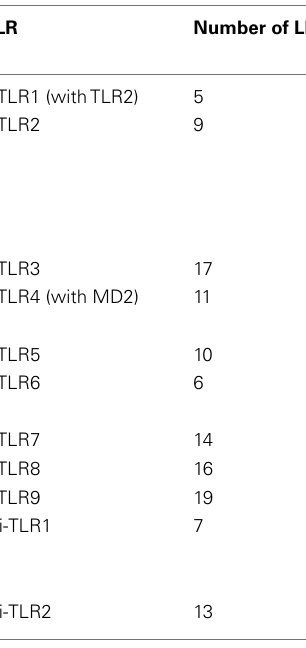
Table 1 | Comparison of human and Ciona